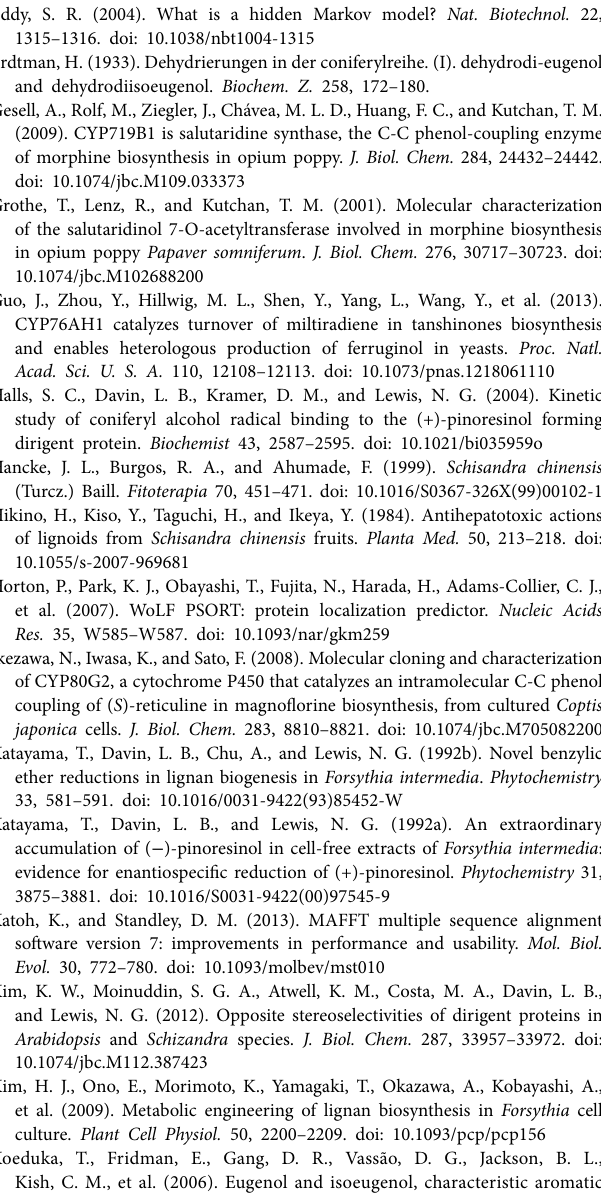
Supplementary Figure 1 | The mass profiles of the S. chinensis fruits and the isoeugenol standard. Supplementary Figure 2 | Gene expression analysis of ScBAHD1 by RT-qPCR at different fruit developmental stages. Supplementary Figure 3 | UPLC analysis of compounds found in a reaction mixture containing purified PhCFAT, alcohol acceptors, and acetyl-CoA after 15 min of incubation. Supplementary Figure 4 | Evaluation of the predicted structure of ScCFAT by Ramachandran plot. Supplementary Figure 5 | Verify-3D graph drawn for the ScCFAT model. Supplementary Figure 6 | Molecular docking of substrate acetyl-CoA with modeled ScCFAT structure in the active site